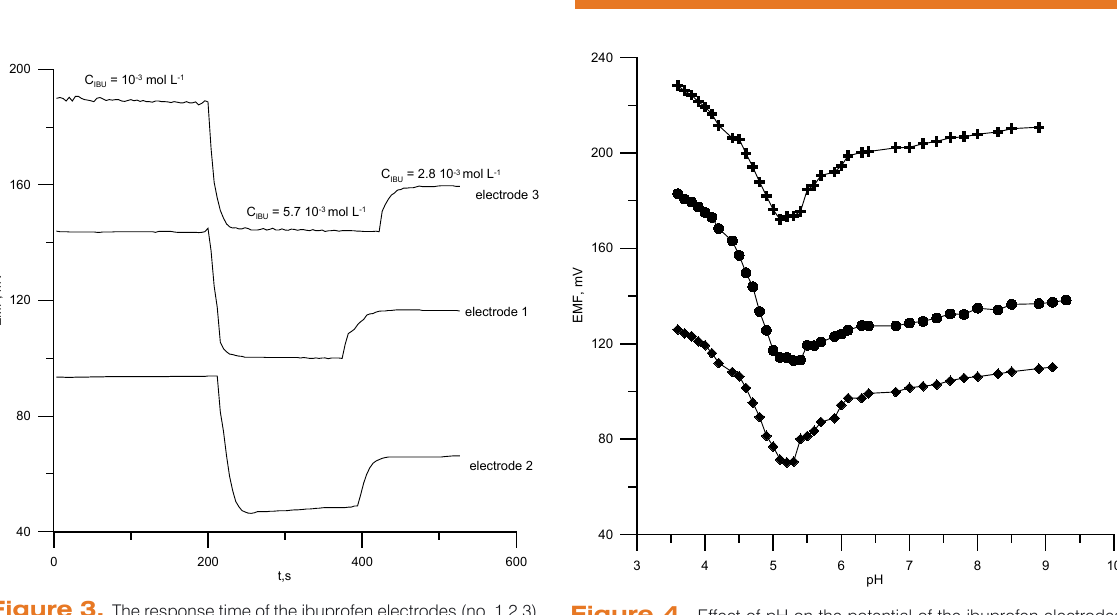
(no.1,2,3) (  ) electrode 1 (DOS), (  ) electrode 2 (o-NPOE), (  ) electrode 3 (DIBP).